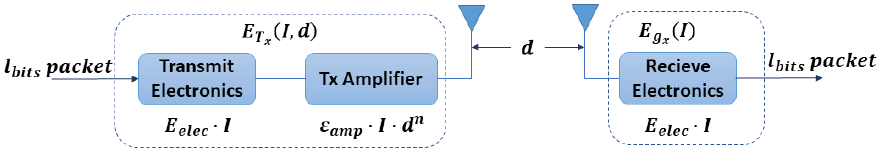
Figure 3. Radio energy